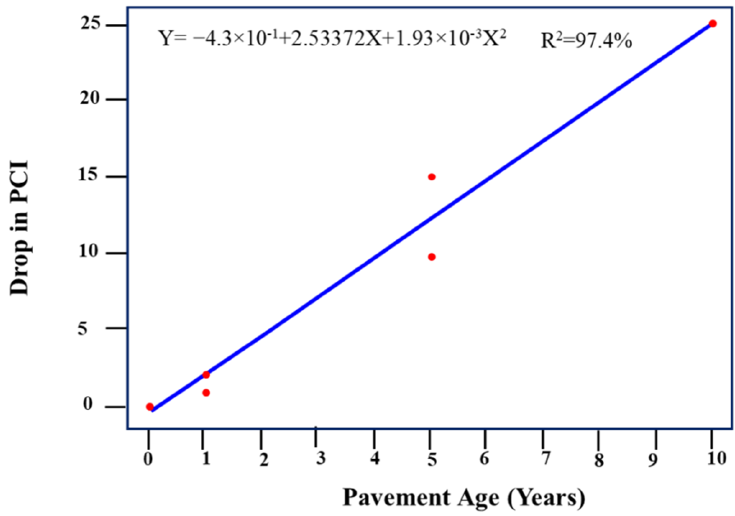
Figure 10. Effect of the overlay on the deterioration of PCI for high traffic.